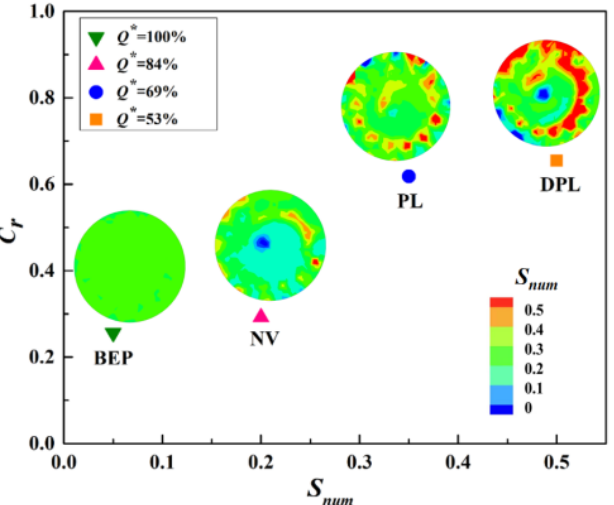
Figure 11. The relationship between the swirl intensity S num and the reduction coefficient C r .